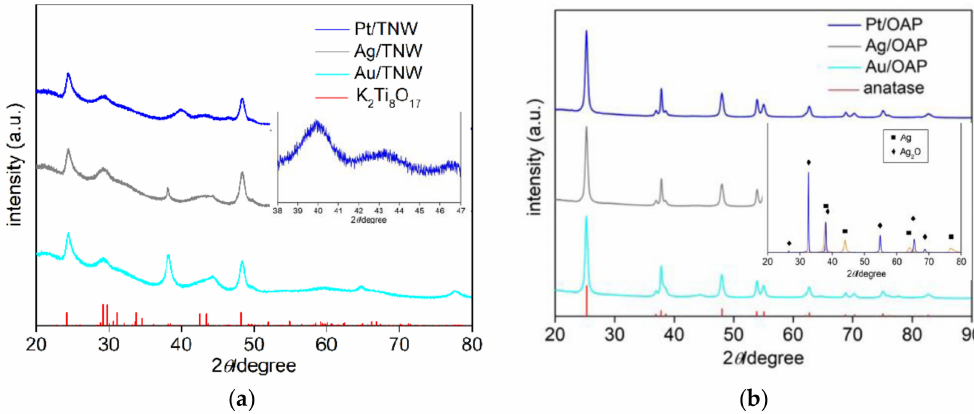
Figure 5. XRD patterns of NM-modified: ( a ) TNW and ( b ) OAP with marked K 2 Ti 8 O 17 and anatase peaks, respectively (red patterns from PDF cards No 9874 and No 8214, respectively); (inserts) XRD patterns of: ( a ) Pt / TNW after subtraction of K 2 Ti 8 O 17 peaks and ( b ) Ag / OAP after subtraction of anatase peaks with marked Ag ( (cid:110) ) and Ag 2 O ( (cid:95)